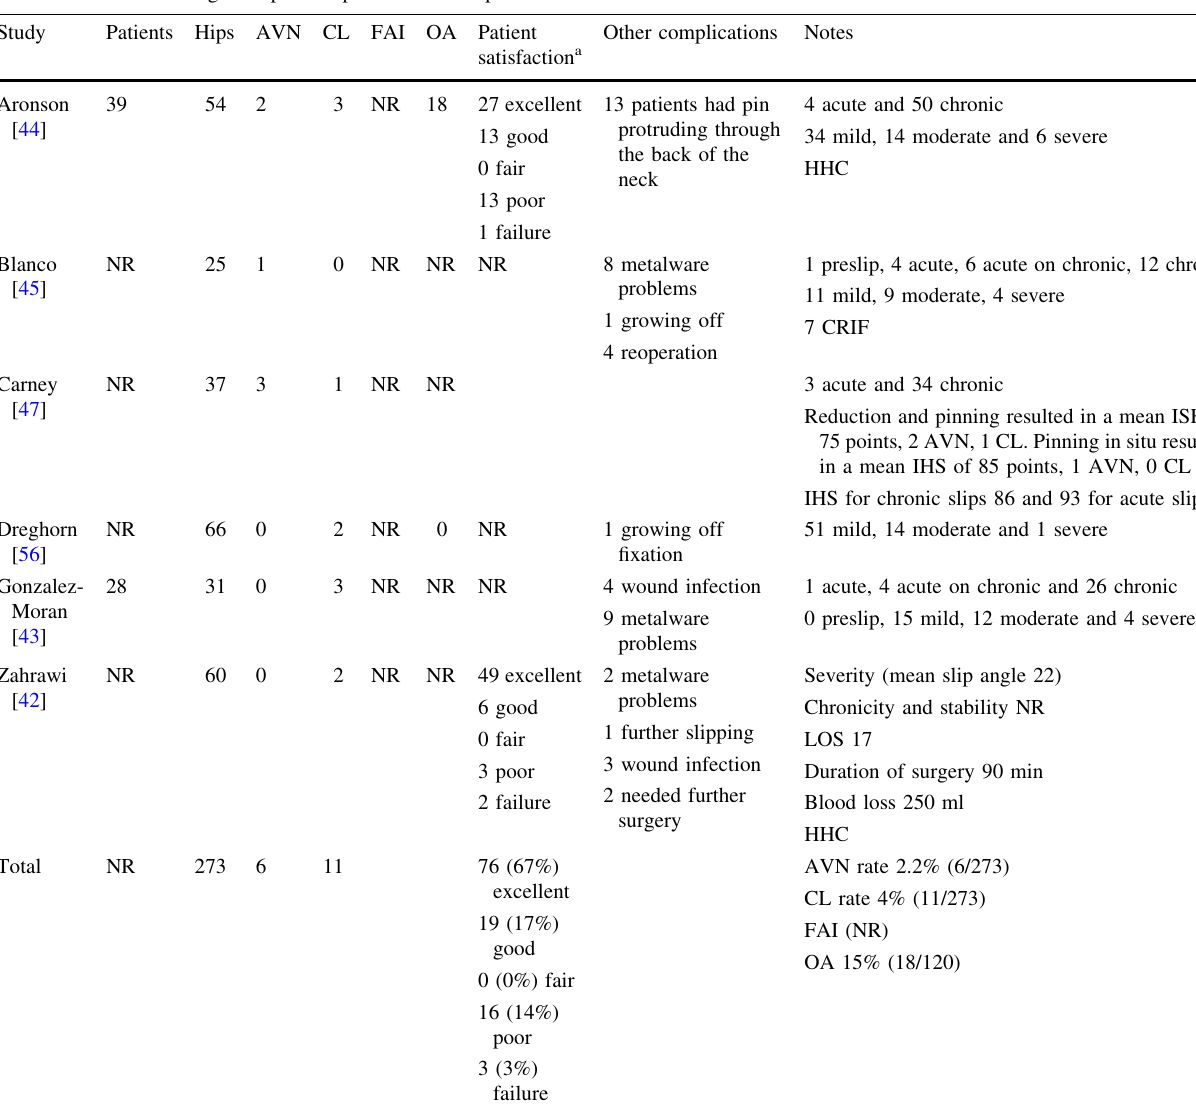
Table 7 Studies of using multiple fine pins in stable slips Study Patients Hips AVN CL FAI OA Patient